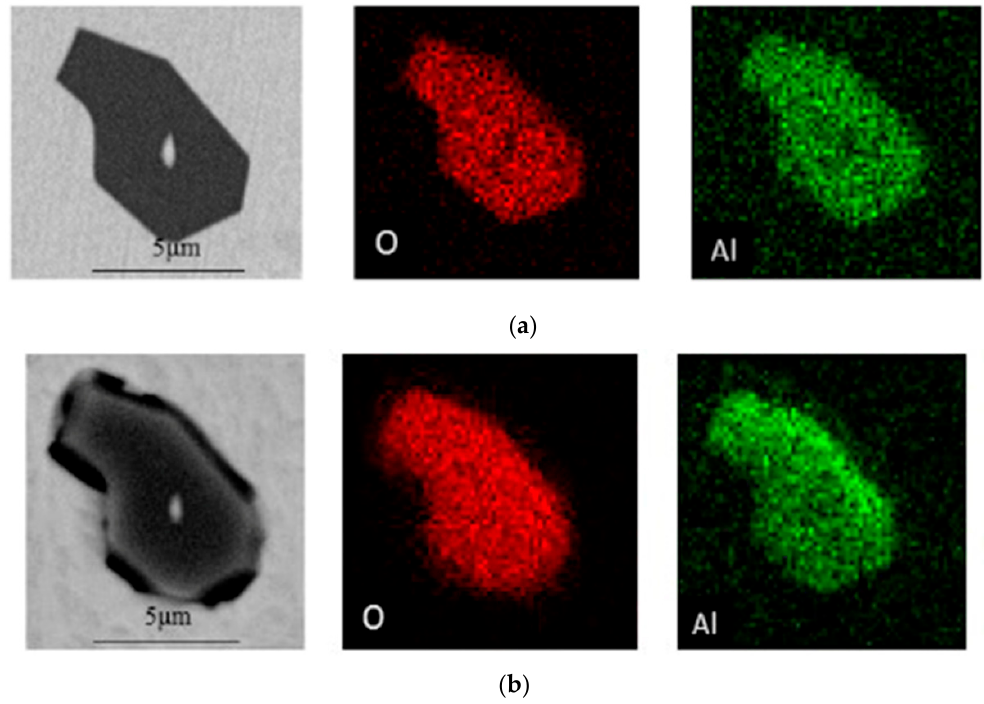
Figure 8. Analysis of Al 2 O 3 inclusions at different immersion times. ( a ) 0 s; and ( b ) 65 s.